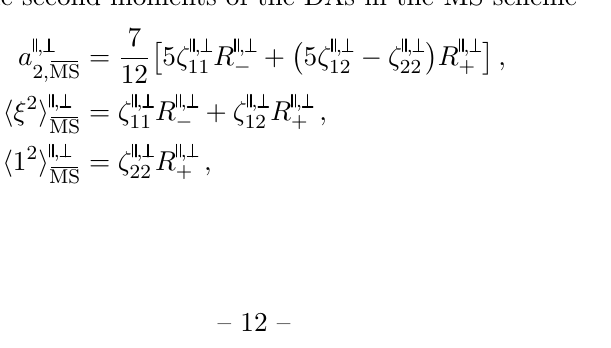
calculated from the time- and momentum- (cid:6) , the error and the (cid:12)tting (cid:6)